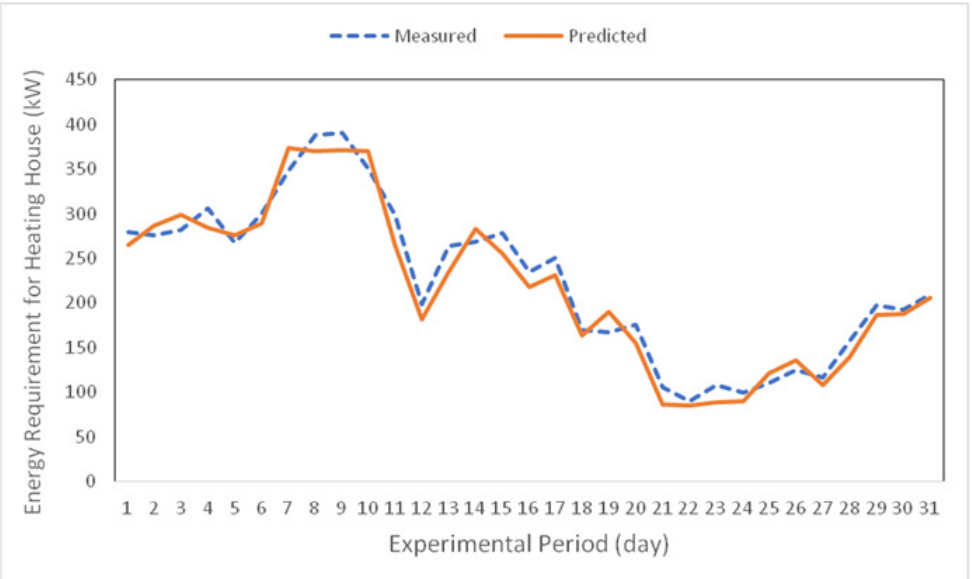
Figure 14. Predicted and measured energy requirement for heating house during winter season.